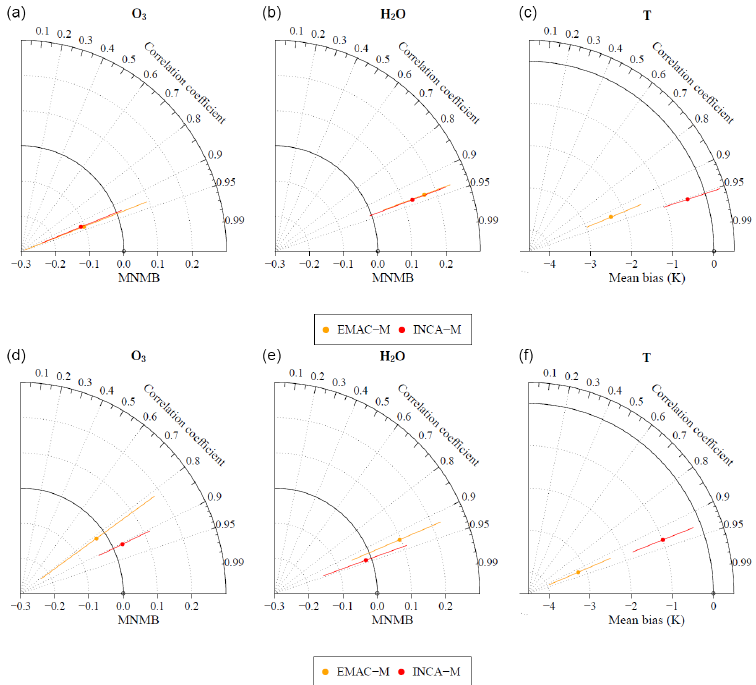
Figure A7. Same as Fig. 4 for summer (a–c) and autumn (d–f)